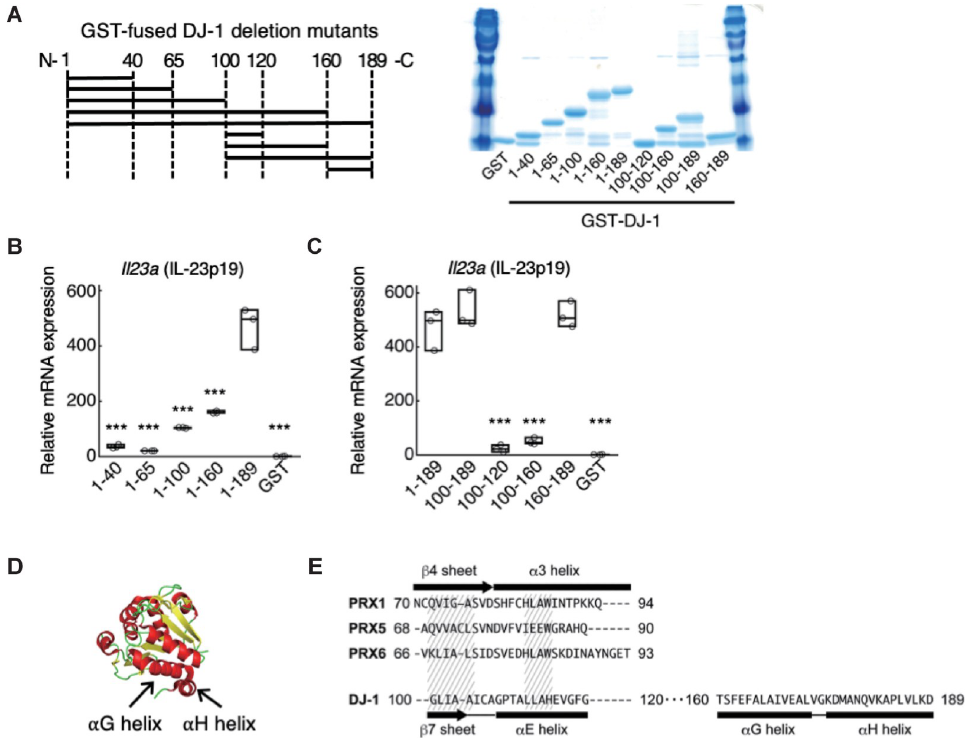
Fig 3. The α G and α H helix region of DJ-1 is essential for DAMP activity. (A) Diagram of generated deletion mutant peptides of DJ-1 fused with GST (left panel). The number of amino acid residues contained in each GST-fused DJ-1 peptide is shown on the x-axis. The amount of generated deletion mutant peptides was examined by SDS-PAGE with CBB staining (right panel). (B) IL-23p19-inducing activities of carboxyl-terminal deletion mutants of DJ-1. (C) IL- 23p19-inducing activities of GST-fused peptides containing the carboxyl-terminal region of DJ-1. (D) α G helix (DJ-1 160– 173 : peptides between residues 160 and 173 of DJ-1) and α H helix (DJ-1 175–189 ) are indicated in the crystal structure of DJ-1 protein (PDB ID: 1P5F). (E) Comparison of peptide sequences among PRX1 70–94 , PRX5 68–90 , and PRX6 66–93 containing the β 4 sheet and α 3 helix of PRXs known to be important for DAMP activity, DJ-1 100–120 containing the β 7 sheet and α E helix, and DJ-1 160–189 containing the α G and α H helix. Similarities among the amino acid residues of PRXs and DJ-1 are indicated by hatched areas. ��� p < 0.001 vs. BMMs treated with DJ-1 1–189 (B, C) (one-way ANOVA with Dunnett correction [ B, C ]). Experiments were performed in triplicate, and the results are representative of 2 independent experiments (B, C) . The data underlying this figure can be found in S1 Data. ANOVA, analysis of variance; BMM, bone marrow–derived macrophage; CBB, Coomassie brilliant blue; DAMP, damage-associated molecular pattern; GST, glutathione-S-transferase; PRX,